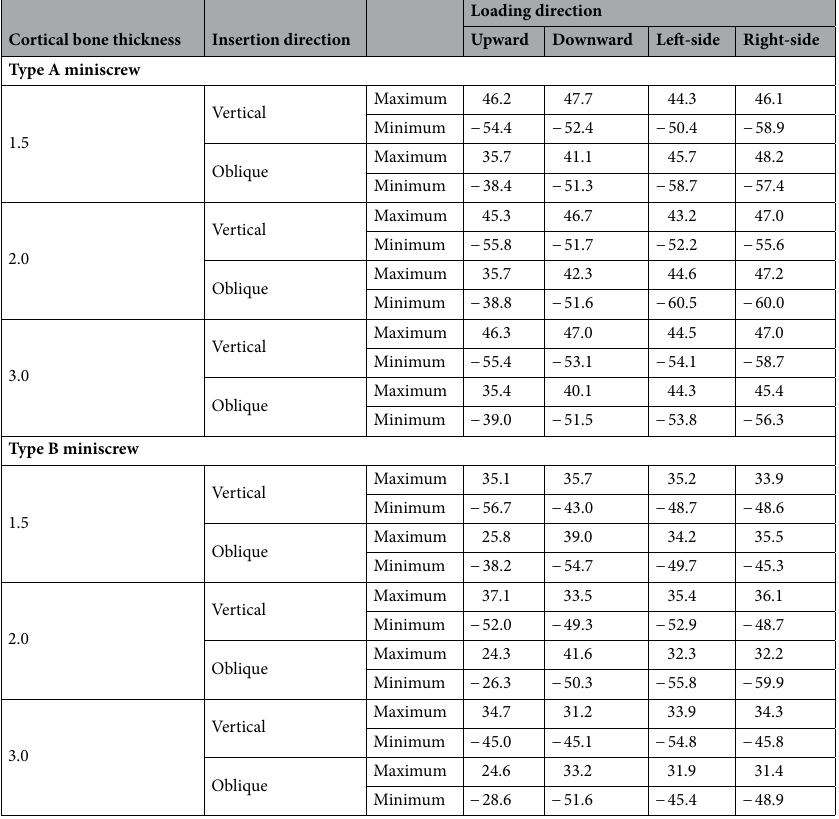
Table 2. Greatest maximum and smallest minimum principal stresses (MPa) on the miniscrew surface when the miniscrew was placed vertically or obliquely in each cortical bone